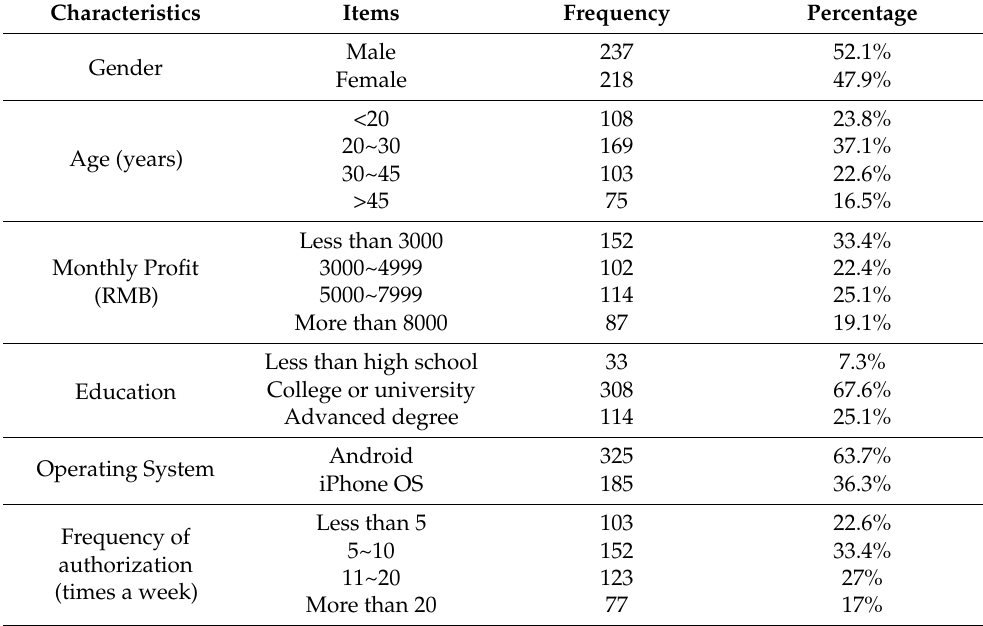
Table 2. Respondent personal